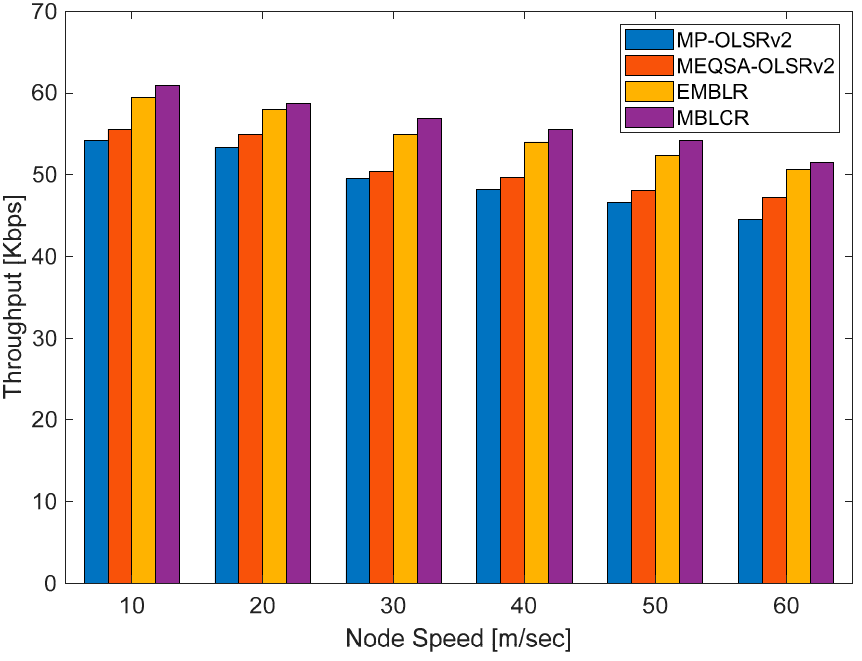
Figure 5. Throughput with various device speeds.